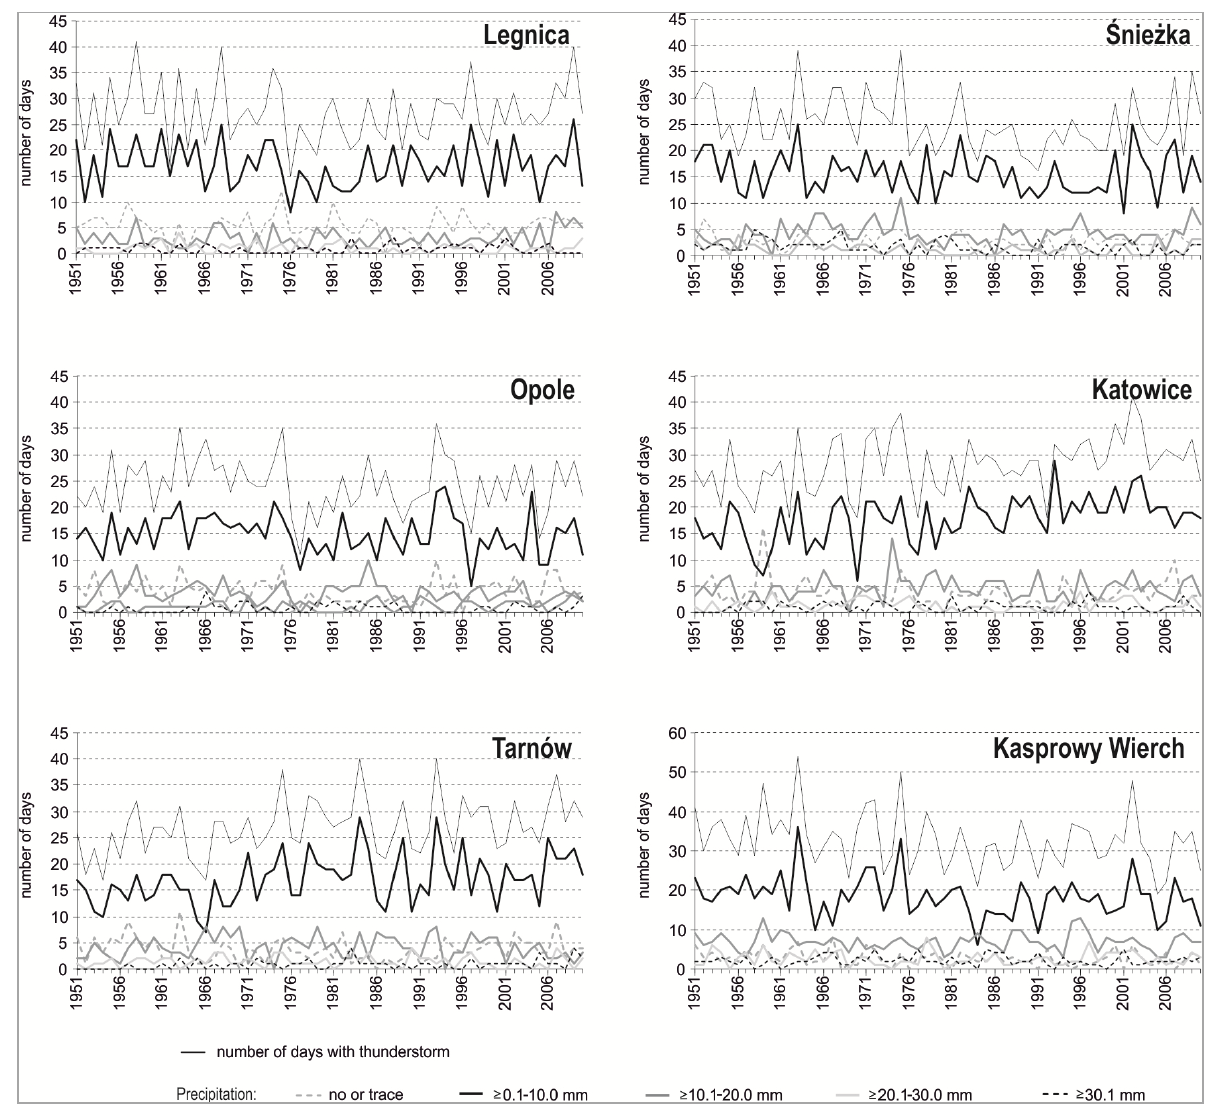
Fig. 4. Number of thunderstorm days with different precipitation categories in the period 1951-2010 – long